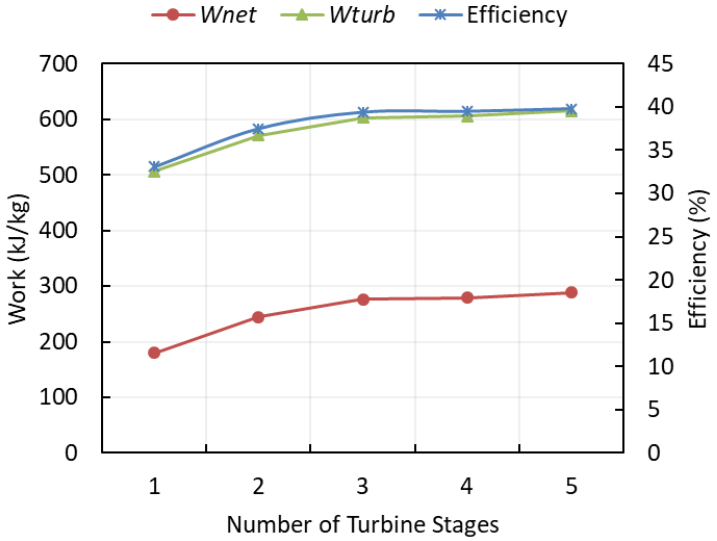
Figure 14. Variation of the turbine work, the net specific work, and the cycle efficiency with the number of turbine stages.